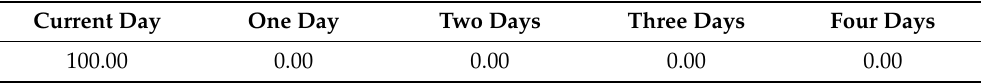
Table 10. Prediction results are based on ratio of R in RGB values without